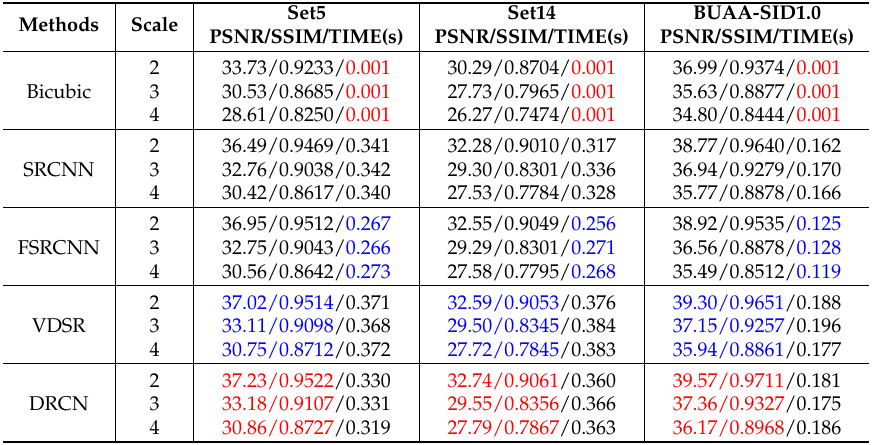
Figure 5. Visualization of super-resolution reconstruction. Table 5. Fixed scale super-resolution results of networks trained on T91 dataset. The red font indicates the best performance, while the blue font indicates the second